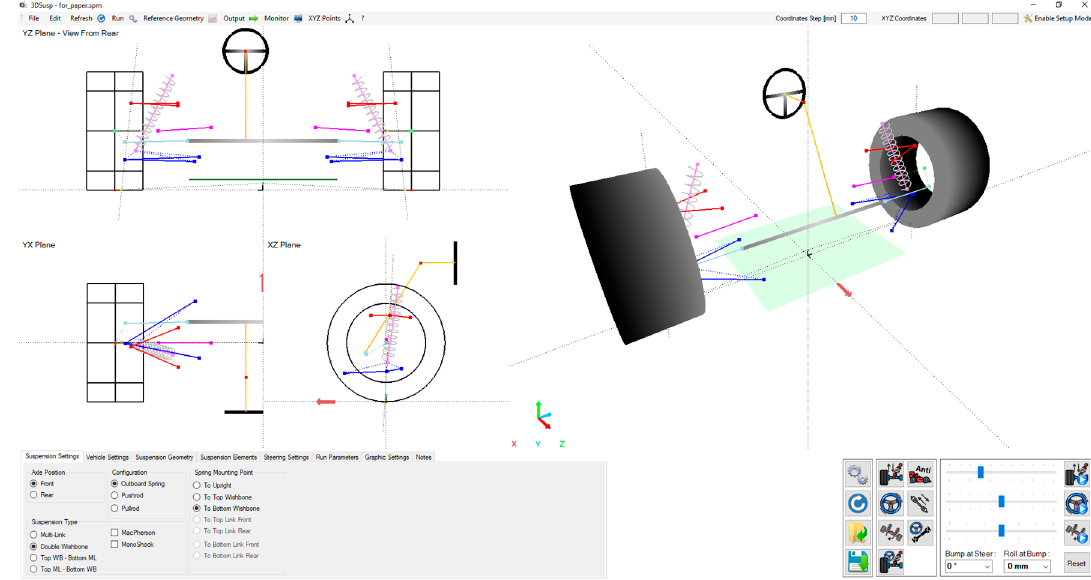
Figure 8. The software tool created by the authors for the design of suspension and steering kinematics.